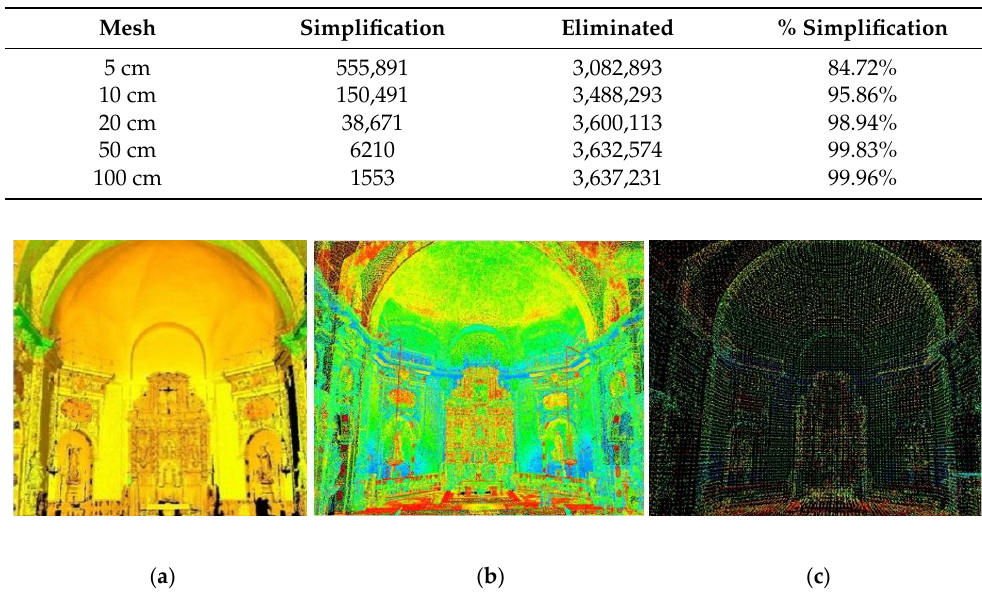
Figure 5. ( a ) Complete original cloud formed by 3,640,000 points. ( b ) Reduced cloud formed by 556,000 points. ( c ) Detail of the reduced vault (points every 20